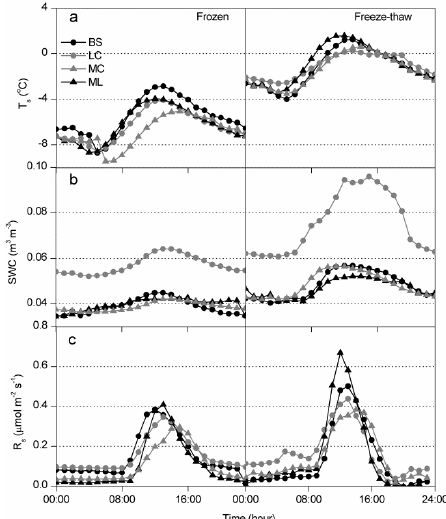
Figure 2. Mean diurnal cycle in soil temperature (T s , a ), soil water content (SWC, b ) and soil respiration (R s , c ) during days when the soil remained frozen (left panels) and days with freeze-thaw cycles (right panels), for four microsites including bare soil (BS), lichen crust (LC), moss crust (MC), and mixed crust of both moss and lichen (ML).